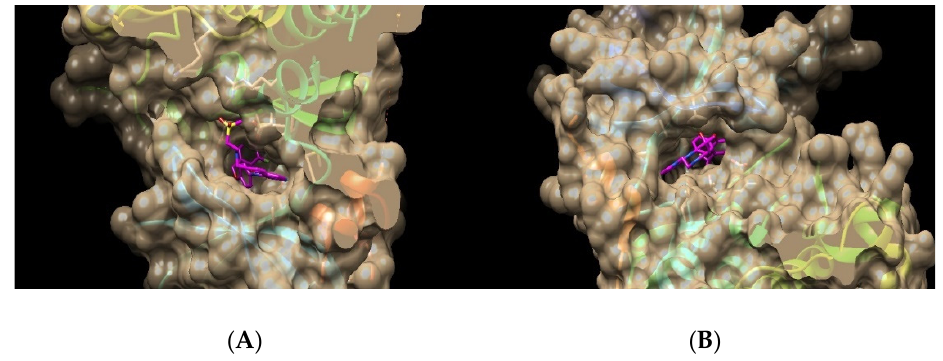
Figure 9. Co-crystallized ligands interactions: ( A ) Lapatinib in EGFR active binding site, ( B ) TAK285 interactions in HER2 active binding site.